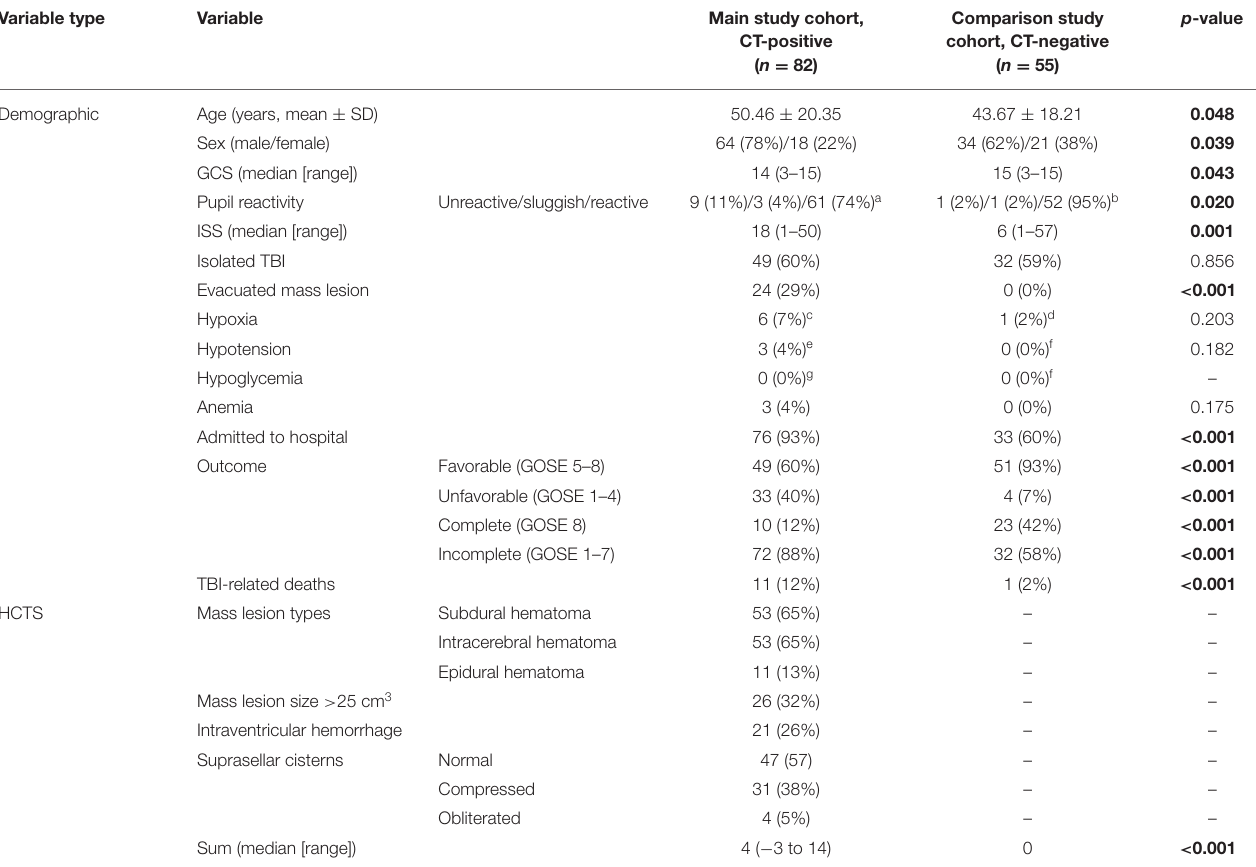
TABLE 1 | Demographics of the whole study cohort—all patients.